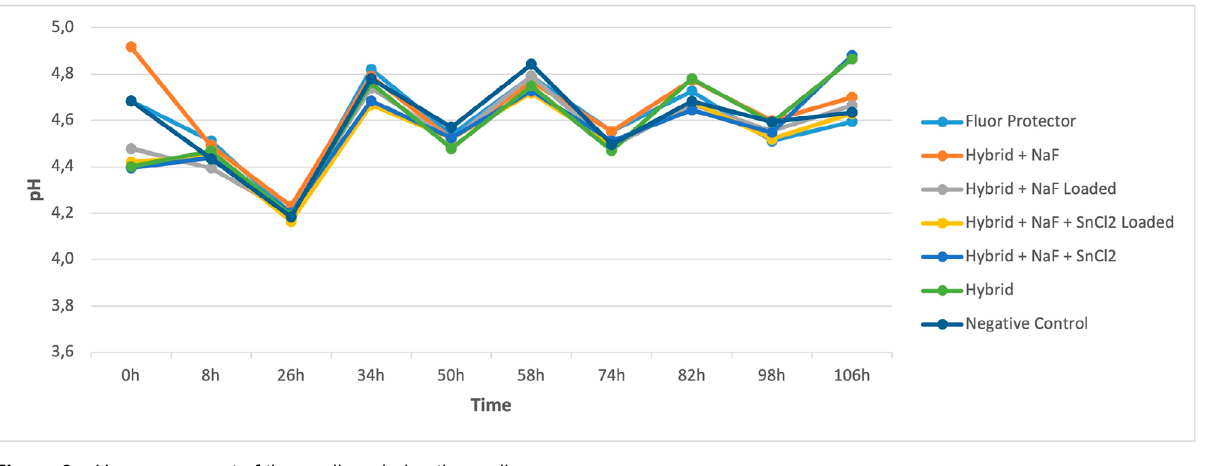
Figure 6- pH measurement of the medium during the cycling